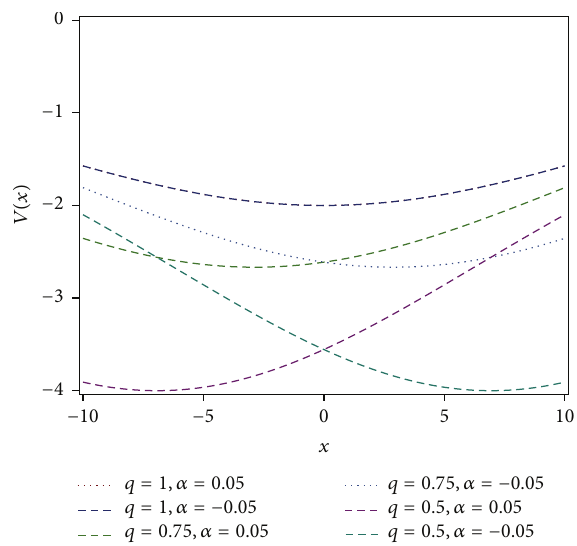
Figure 2: The plot of the qHPT potential as a function of position with 𝑞 = 3, 𝛼 = 1, 2, and 3 for 𝑥 < 0 and 𝑥 > 0, respectively.